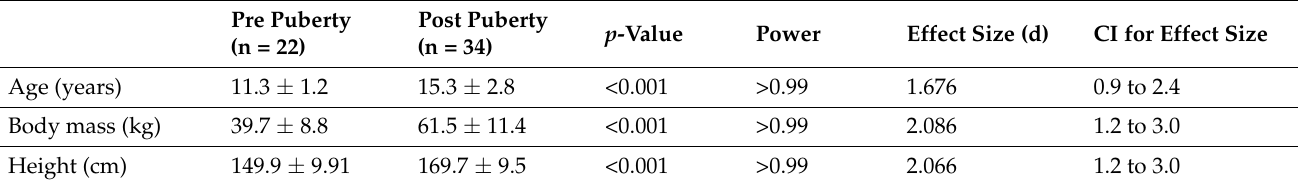
Table 1. Anthropometric data of the boys in the study.